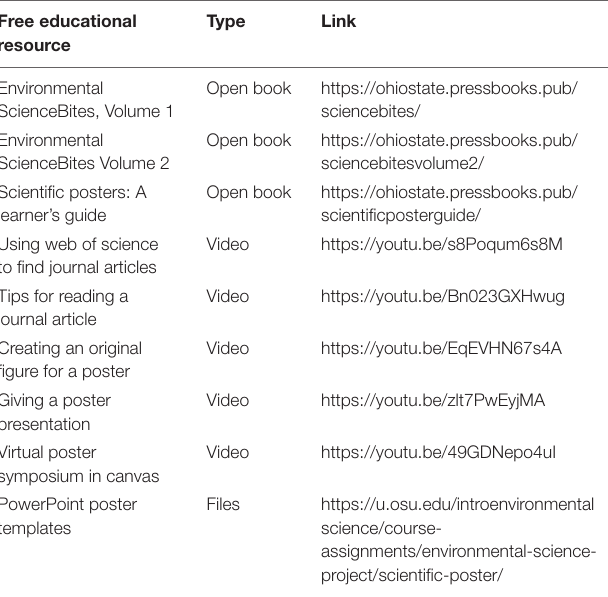
TABLE 3 | Free resources (i.e., books, how-to videos, downloadable files) for instructors and students. Free educational